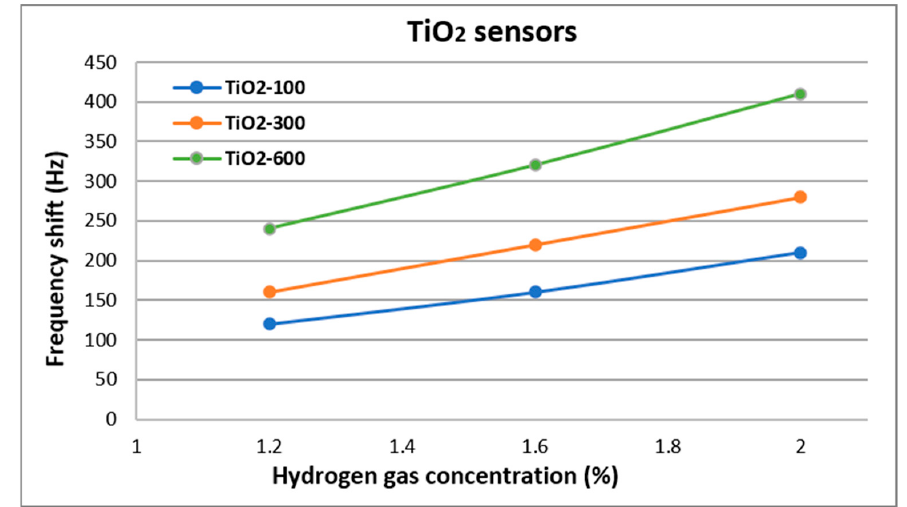
Figure 6. Frequency shift of the TiO 2 sensors at different hydrogen concentrations.